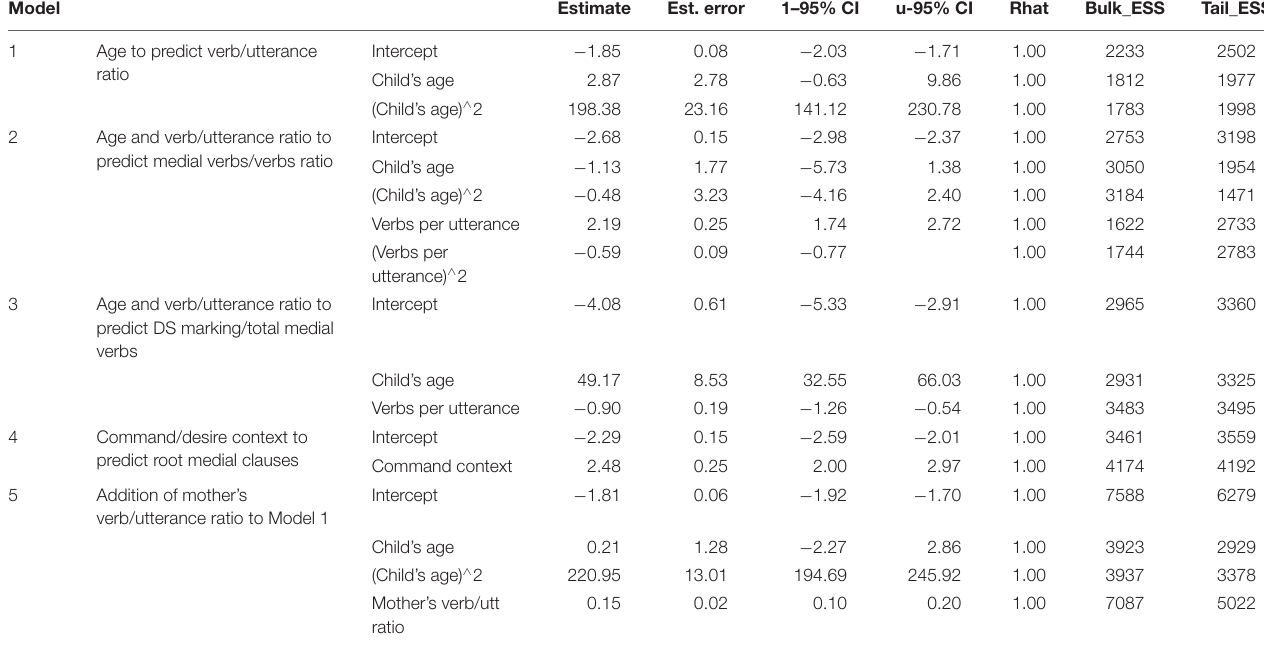
TABLE 3 | Population-level effects for Bayesian linear